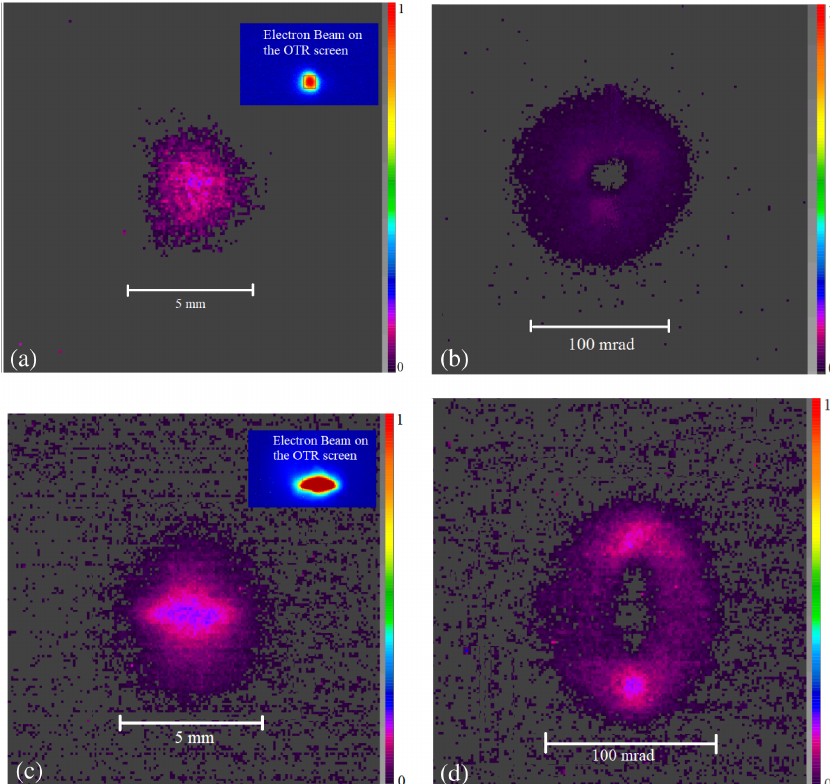
FIG. 6. Far field and near field images (color palette in arbitrary units) of CTR over the whole spectral range of emission. Images (a) and (b) show the near and far field CTR distribution, respectively, for a symmetric round electron bunch. Images (c) and (d) show the near and far field CTR distribution, respectively, for an asymmetric electron bunch, demonstrating the possibility to control the energy distribution of the radiation both in near and far field via a transverse shaping of the bunch (size and divergence at the source plane). Electron beam parameters (per single bunch): 215 MeV, 1.5 ps, 40